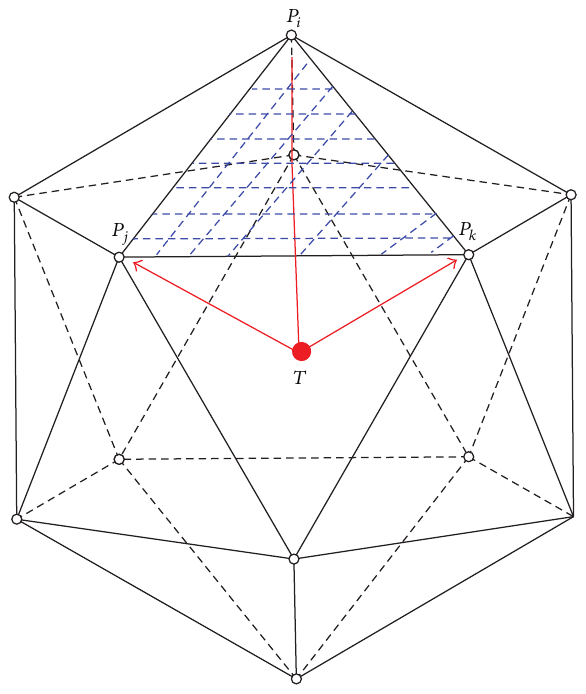
Figure 3: Establishment of the emitted ray tube.